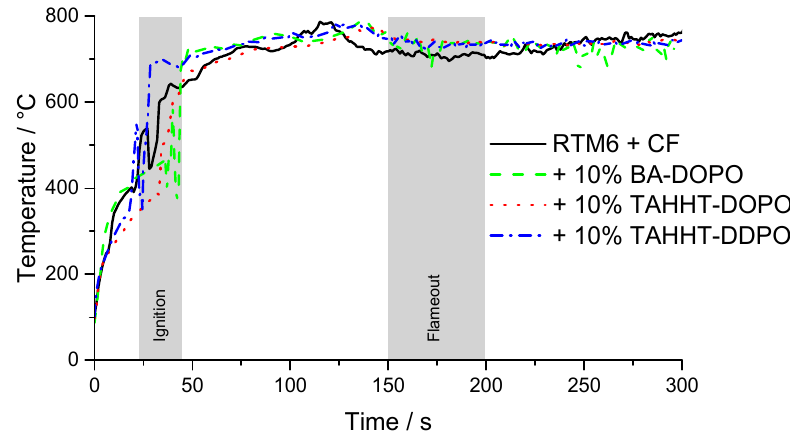
Figure 11. Temperature at the sample surface during irradiation (60 kW·m − 2 ) measured by a thermocouple attached to the surface.